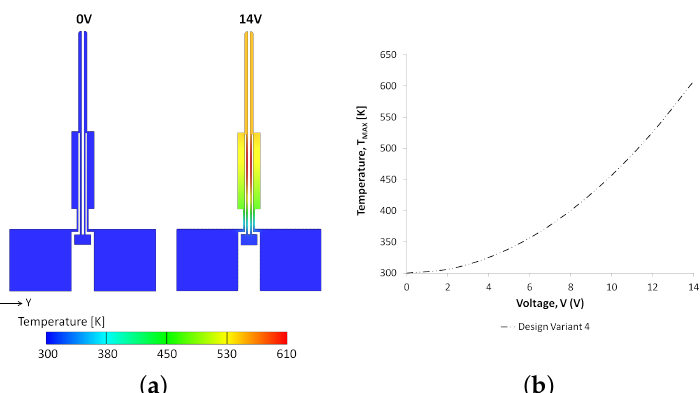
Figure 9. Simulated steady-state temperature distribution on the single crystal silicon microgripper structure fabricated with SOIMUMPs TM (Design Variant 4): simulated temperature plots showing the distribution with and without an applied potential ( a ), and variation of the maximum temperature, T MAX , with applied potential ( b ). The maximum temperature, T MAX , of the actuated microgripper structure at 14 V is 610 K and is located on the hot arm as shown in ( a